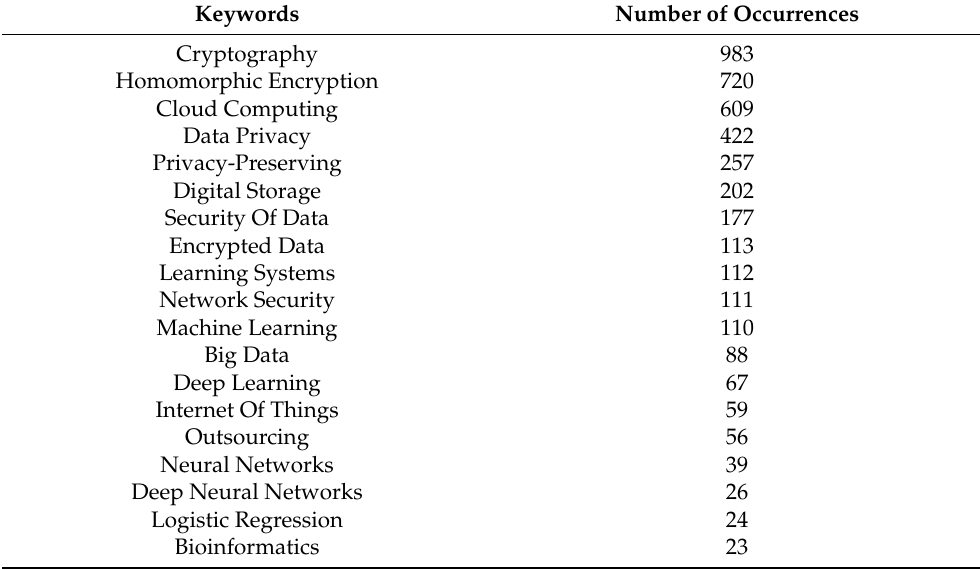
Table 8. Statistics of some